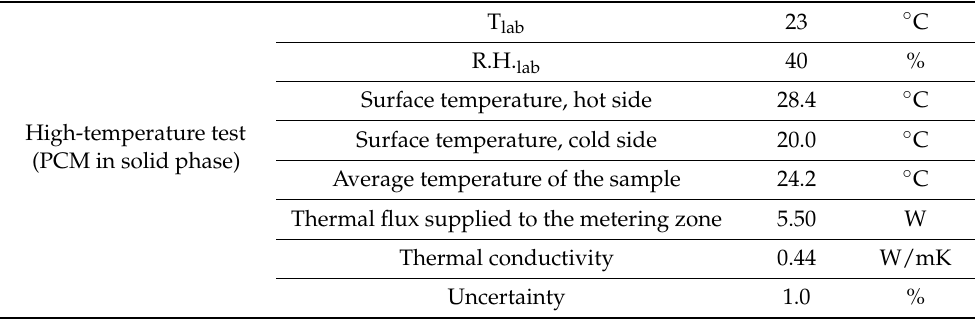
Figure 4. Sample during the hot ‐ plate analysis.